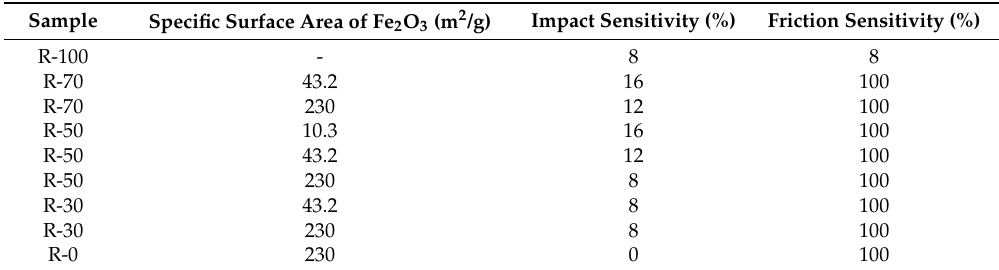
Table 1. Mechanical sensitivities of Al/Fe 2 O 3 /RDX